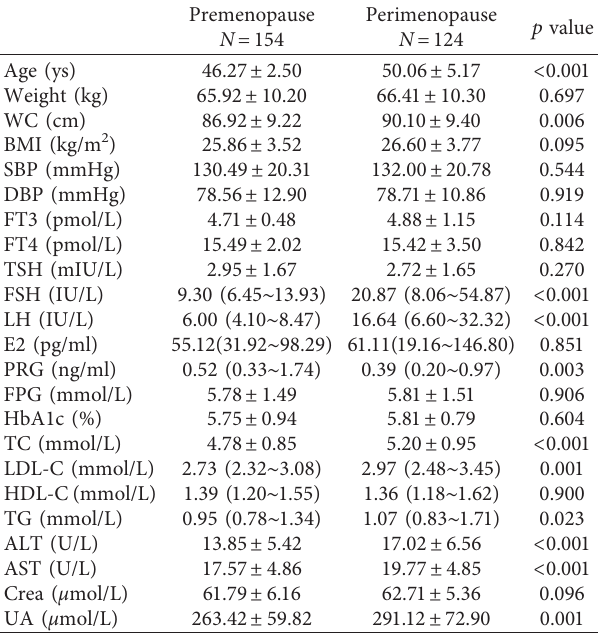
Table 1: The characteristics of the study population. Premenopause